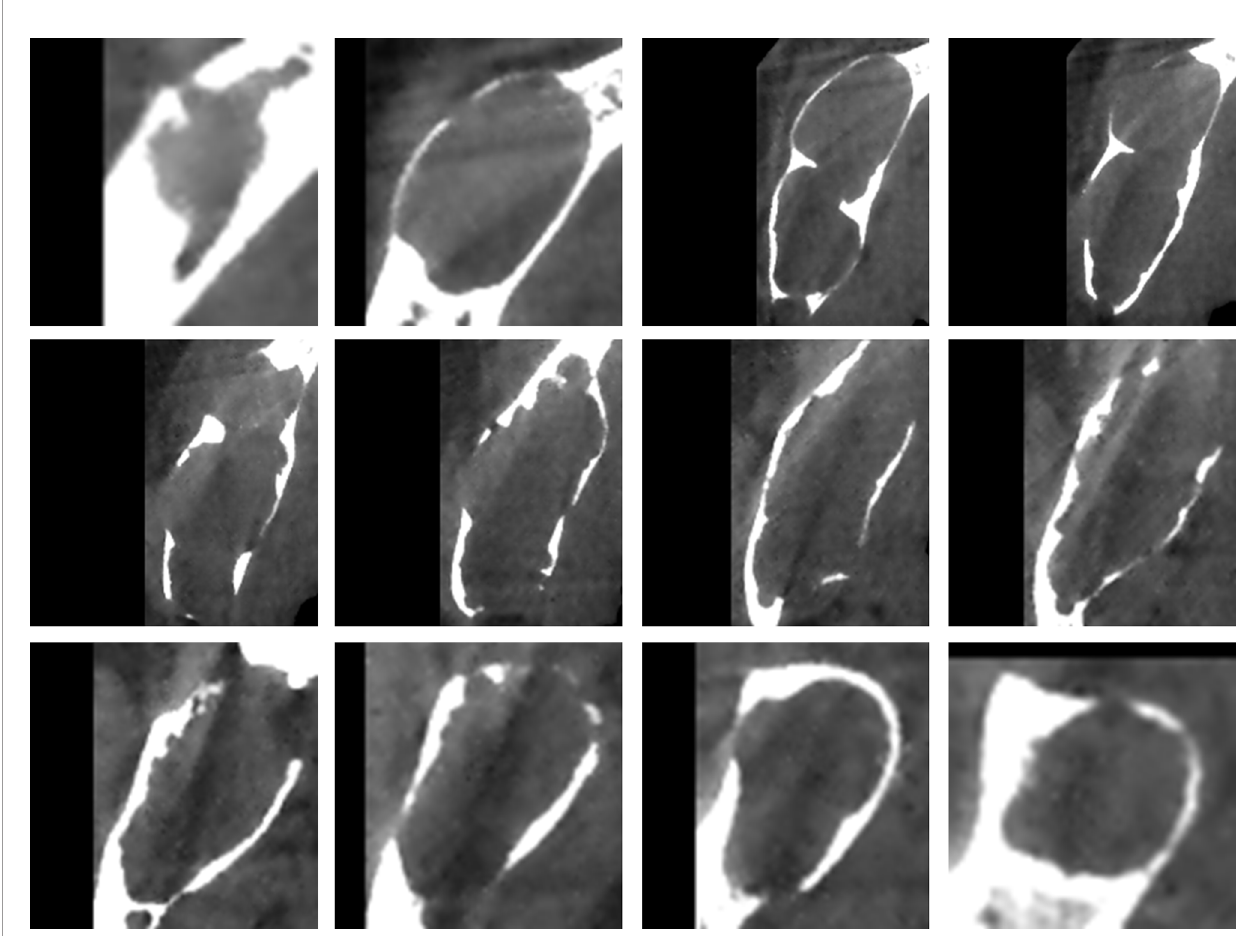
FIGURE 3 | The images used for training were obtained after a series of processing steps, and these 12 images came from one patient.